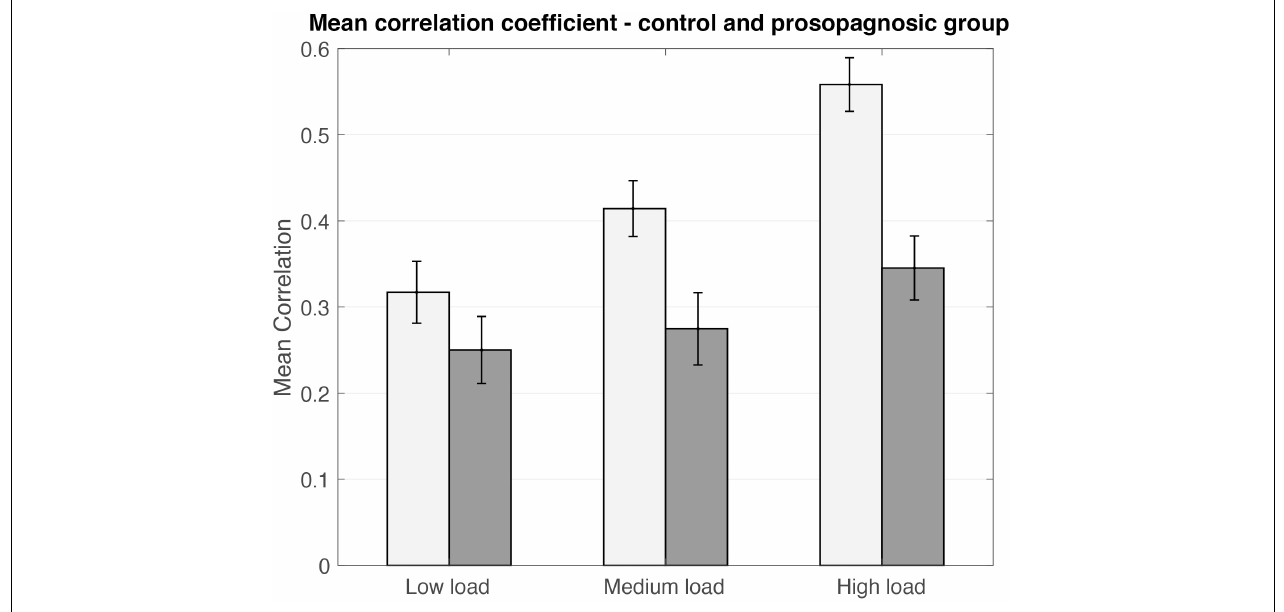
FIGURE 5 | Mean correlation coefficients plotted for control and prosopagnosic group for the different memory conditions including standard error of the mean. Statistical comparison is performed via Donsker’s